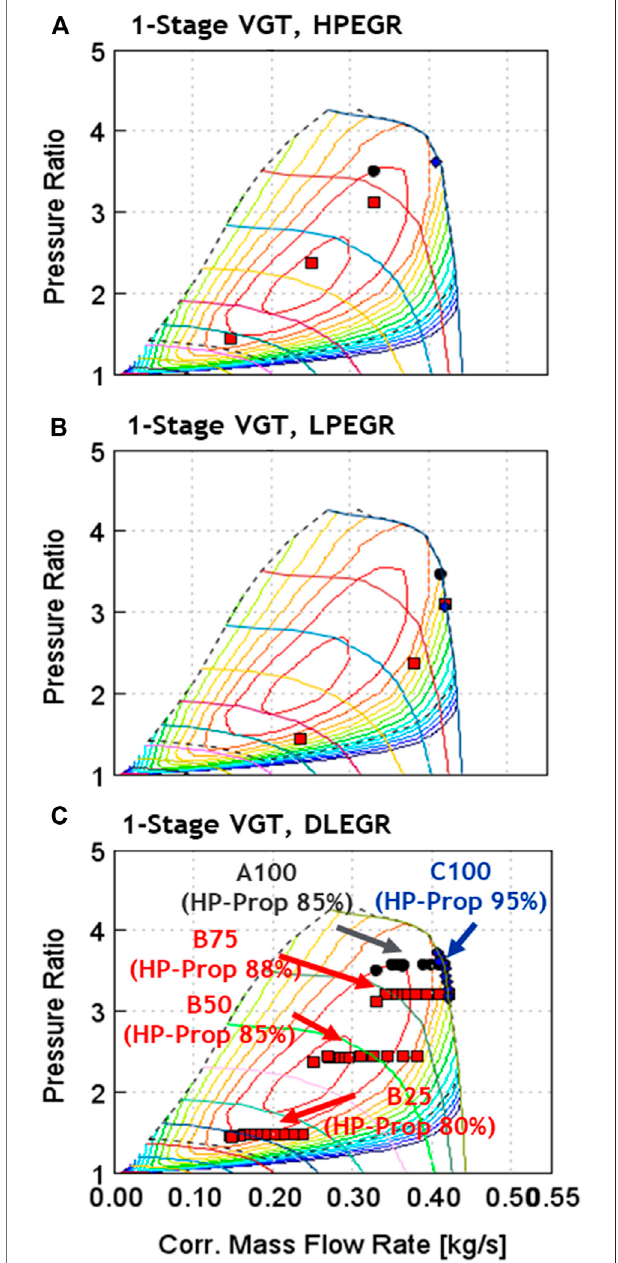
FIGURE 10 | Turbocharger-Engine matching for the advanced 1-Stage VG Turbocharger using (A) HPEGR, (B) LPEGR and (C) DLEGR con fi gurations.